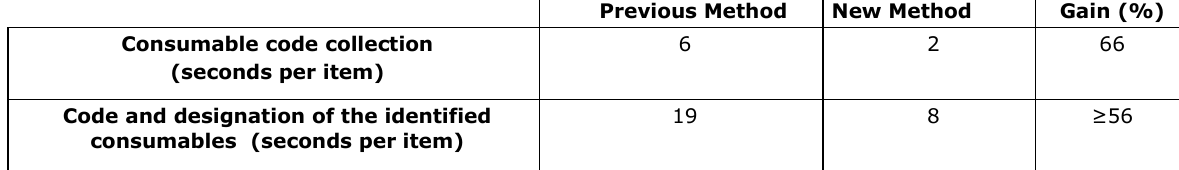
Table 2. Gains from the new implemented method to identify consumable